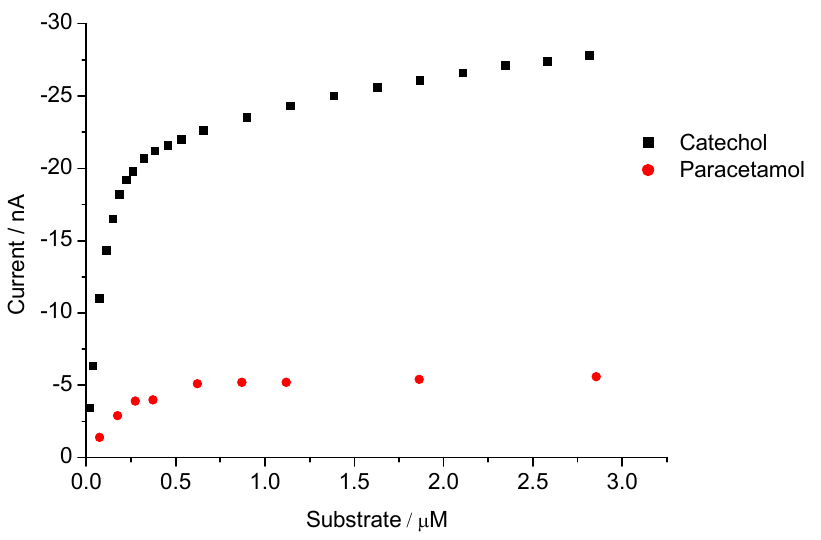
Figure 5. Concentration dependence for catechol and paracetamol at 0 V of the